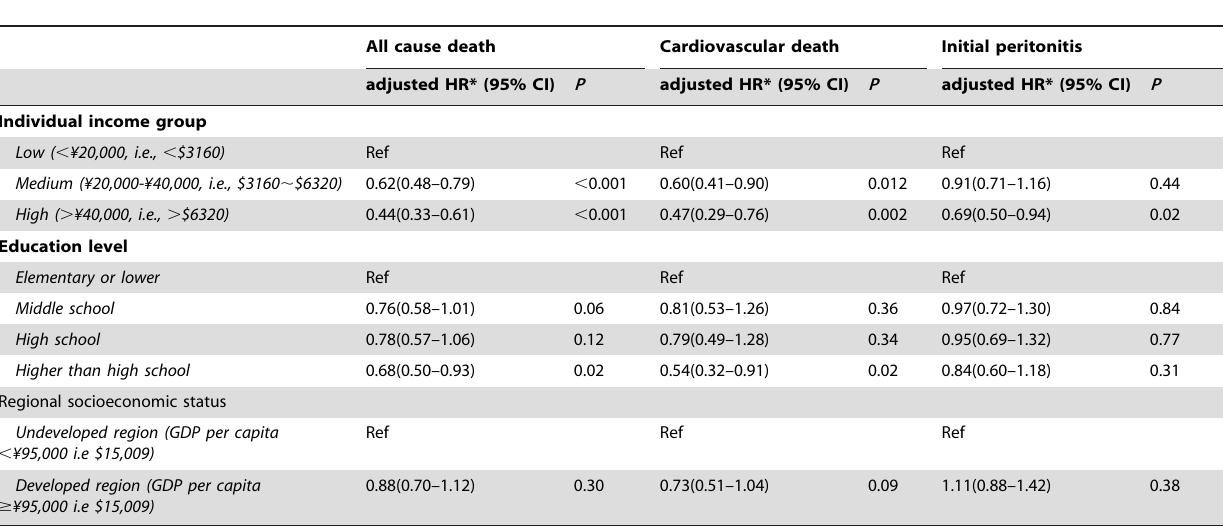
Table 4. Predicting the roles of individual income and education level in all-cause death, cardiovascular death, and initial